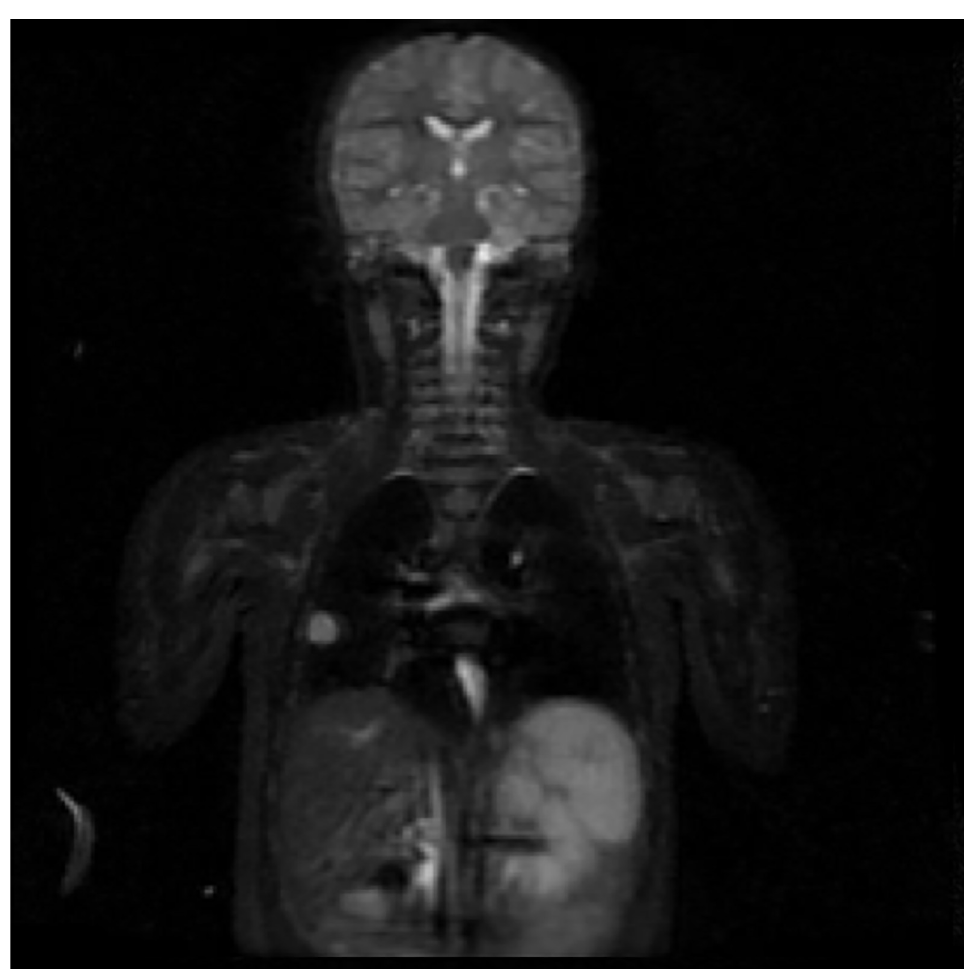
Fig 5. A well-characterized pulmonary nodule in a pediatric patient during follow up for Ewing’s sarcoma.